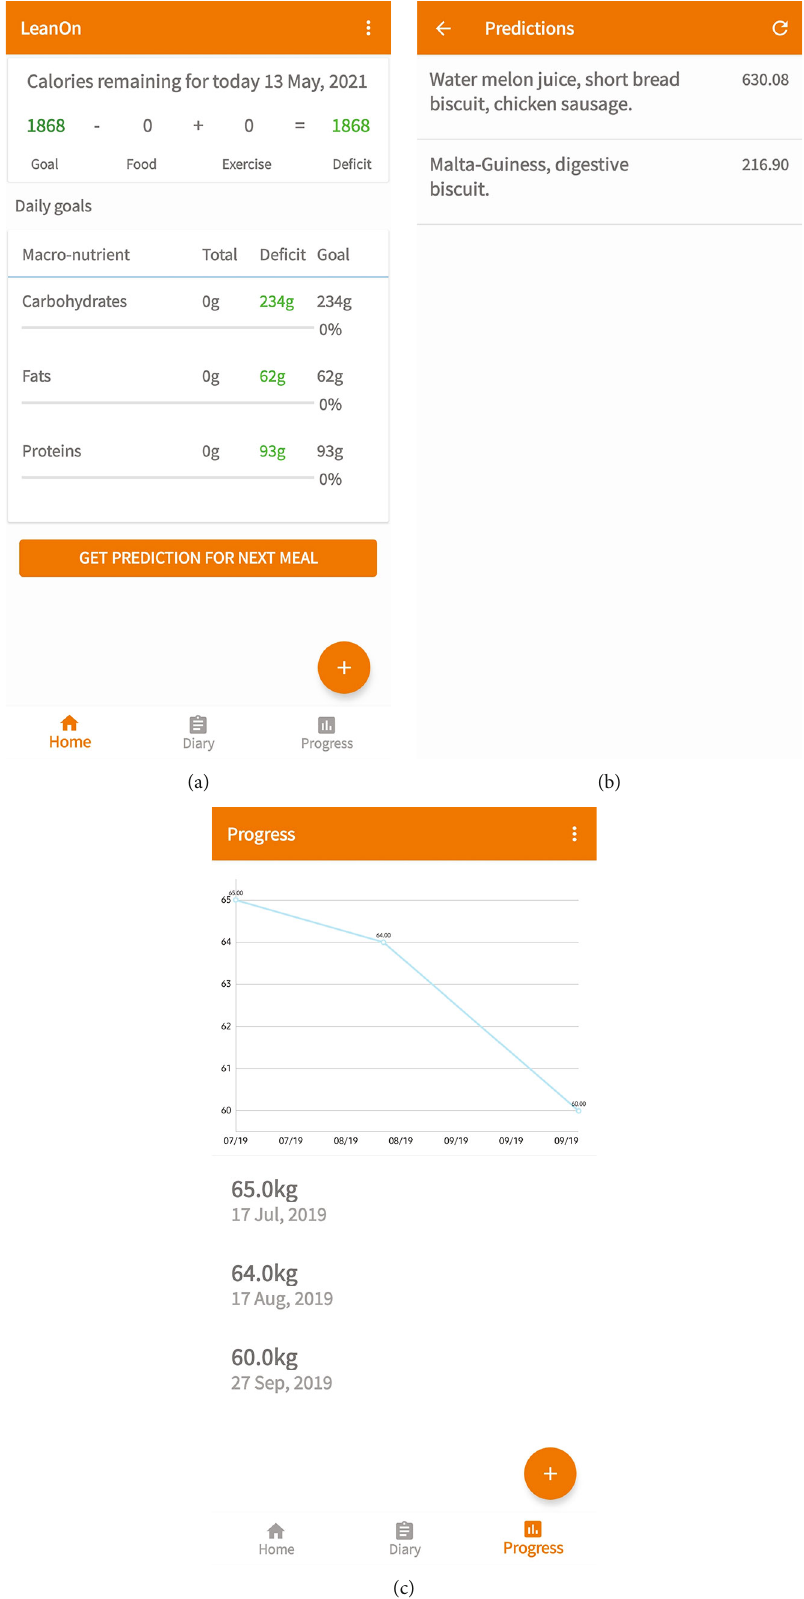
Figure 8: User interface report showing (a) daily calorie and macronutrient summary, (b) meal prediction results, and (c) progress chart of weight loss over